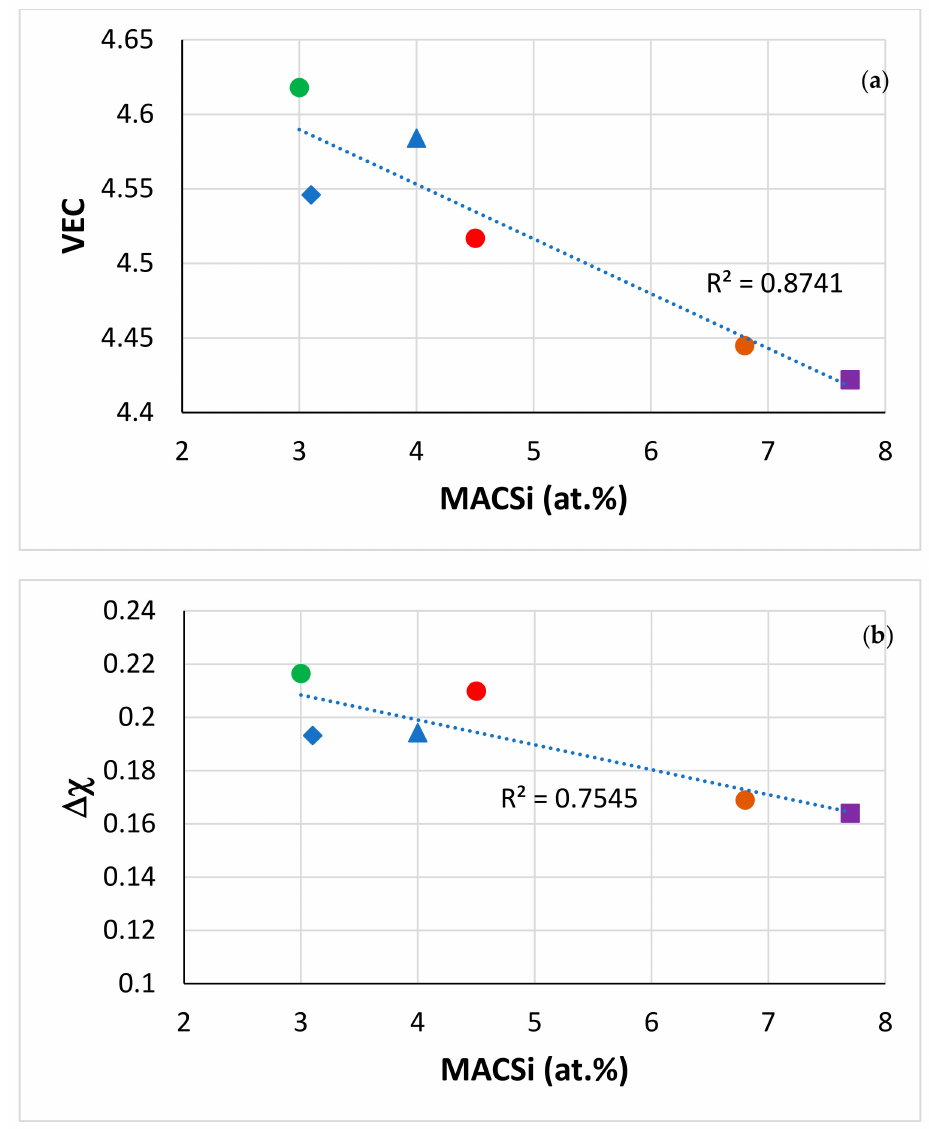
Figure 8. ( a ) VEC versus macrosegregation of Si (MACSi) and ( b ) ∆ χ versus MACSi of RCCAs studied in our research group. Data are as follows: green alloy JZ4, red JZ5, orange OHS1, square EZ8, triangle JZ3, diamond JZ3 + , for nominal compositions of alloys see the Abbreviations. If the data for JZ3 + were to be excluded (for the reasons discussed in [47]) in ( a ) R 2 = 0.9537 and in ( b ) R 2 =